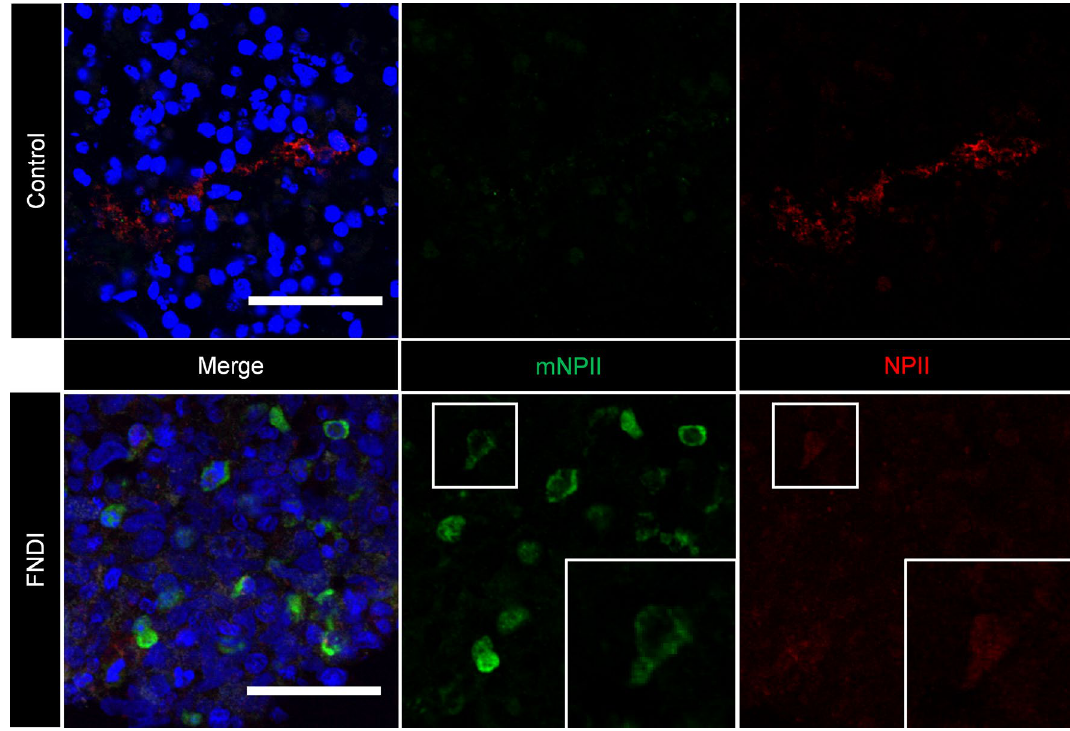
Figure 4. FNDI-specific hiPSCs generated mutant NPII. Expression of normal NPII (red) was observed in SFEBq from FDI-02. Additionally, the expression of mutant NPII (mNPII) (green) was confirmed, which was not expressed in 201B7-derived AVP neurons. For all relevant panels, nuclear counterstaining was performed with DAPI (blue). Scale bars, 50